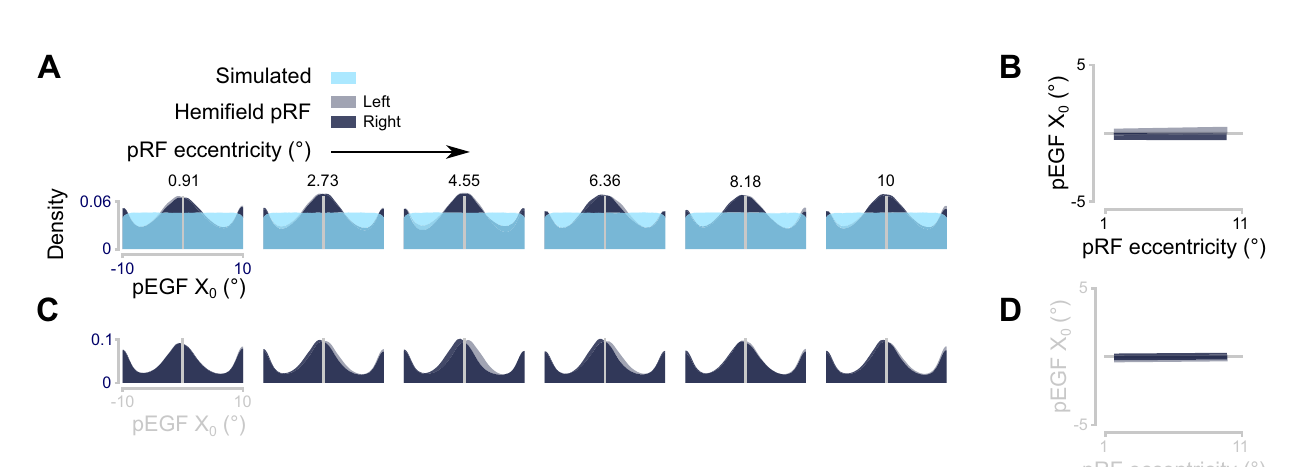
reverses. C MedianpEGFX 0 asafunctionofpRFeccentricityinV1.Colorsfollowthe same conventions as in B . Circles and triangles represent the group median pEGF X 0 perpRFeccentricitybinandarescaledaccordingtothenumberofvoxelsinthat bin. Lines represent the least squares solution through the points. D Median pEGF X 0 asa function of pRF eccentricity forthe other visualROIs,alldrawnto the same scale as in C . In all panels, the lighter color and circles represents pRFs in the left hemi fi eld,thedarkercolorandtrianglesrepresentspRFsintherighthemi fi eld.See Figure S6A for the same plots for individual participants and S6C for the same results using a different con fi guration of the retinotopic representation of the visual input. Source data are provided as a Source Data fi le.